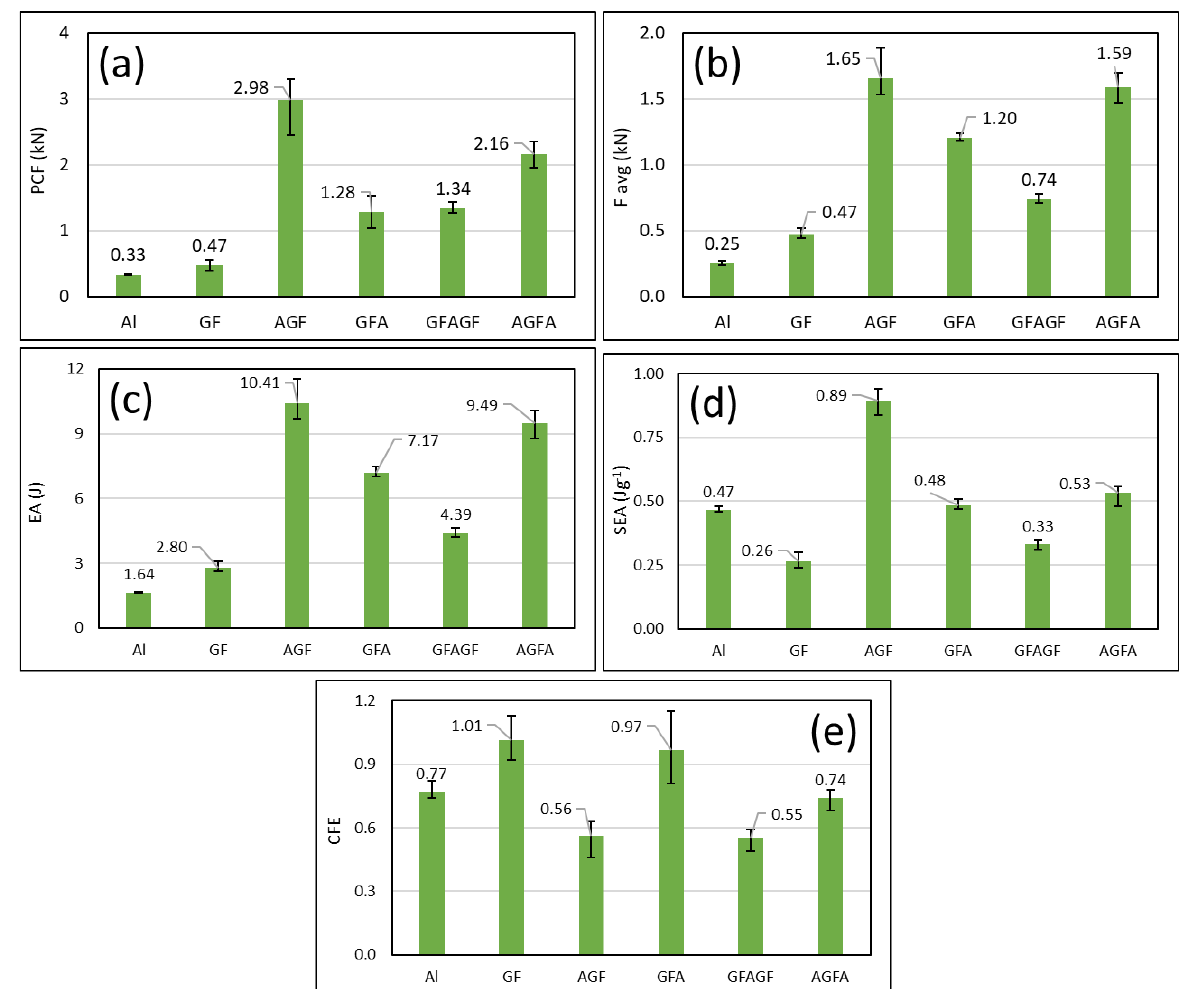
Figure 11. Lateral crashworthiness indicators of each specimen load and displacement curve of ( a ) peak crushing force (PCF), ( b ) F average, ( c ) energy adsorption (EA), ( d ) specific energy absorption (SEA), ( e ) crush force efficiency (CFE).